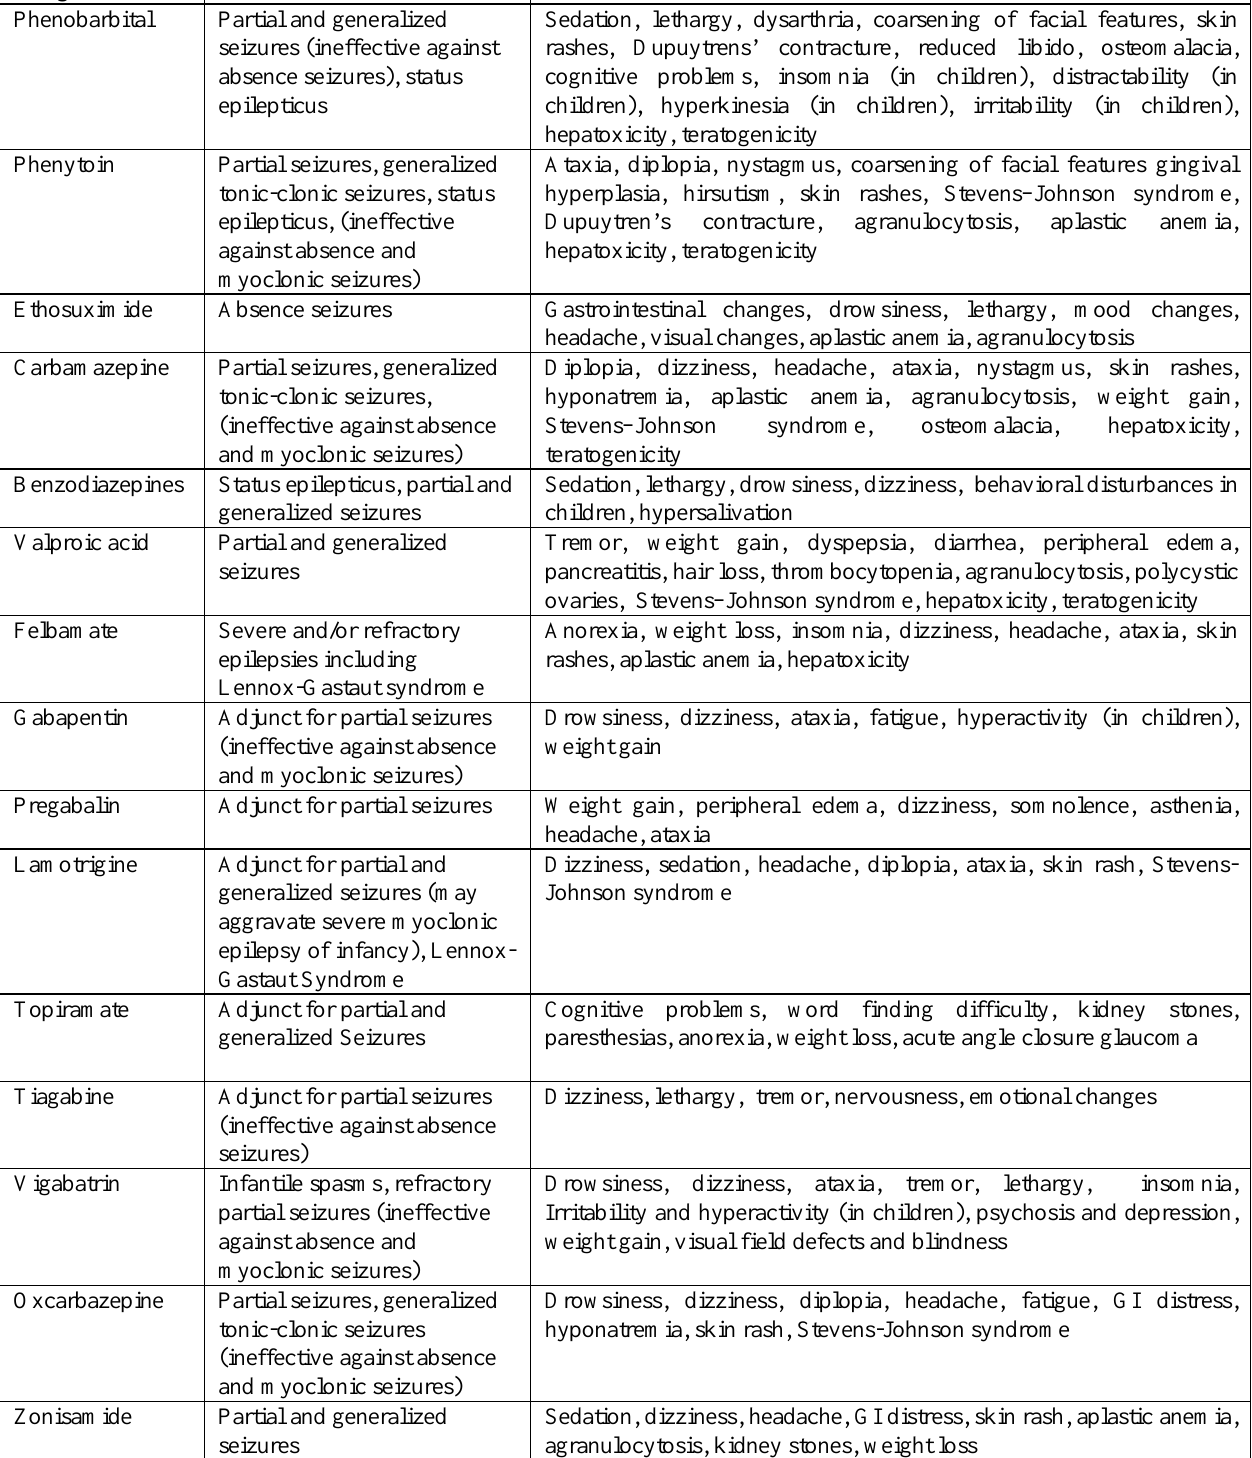
Table 1. Clinical uses in common seizure types and syndromes and adverse effects of antiepileptic